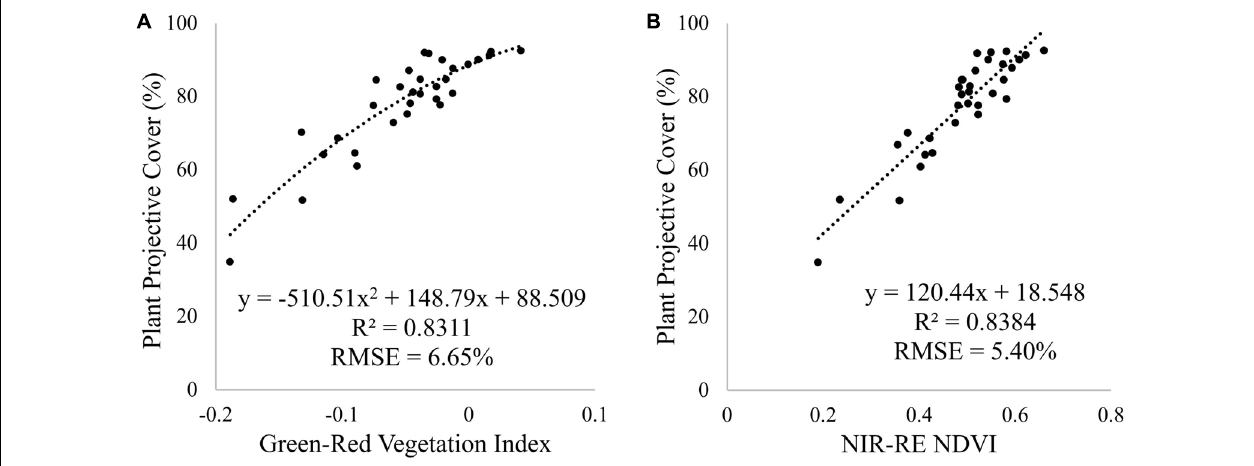
FIGURE 8 | Relationship between field measured PPC and (A) the Green-Red Vegetation Index and (B) NIR-RE NDVI derived from the UAV RGB and multi-spectral imagery, using a second order polynomial and linear regression, respectively. The best-fit equations were used to predict PPC for all tomato plants. These relationships were based on field and UAV imagery acquired on January 7,